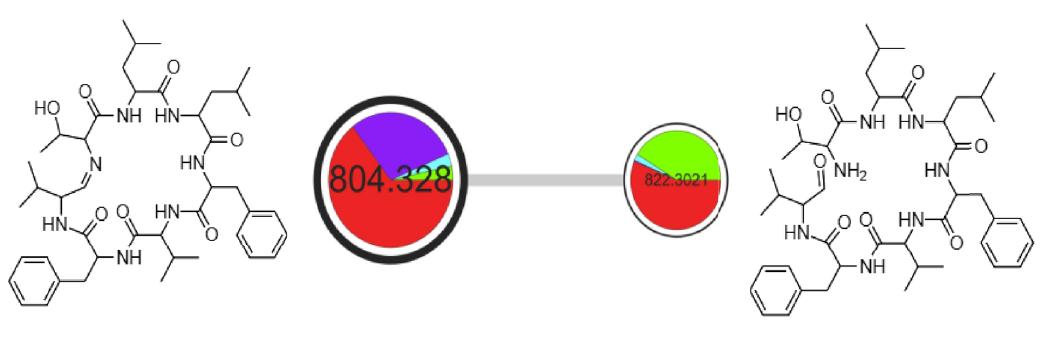
Figure 2. Characterization of koranimine from Peribacillus frigoritolerans BE93. ( a ) Relative abundance of the detected spectral features in tryptic soy broth (TSB) medium. Asterisk (*) represents koranimine. ( b ) Koranimine molecular network showing the structure of koranimine and its open aldehyde form. Pie chart represents relative abundance in each culture medium. ( c ) Elucidated tandem mass (MS/MS) fragmentation pathways of koranimine. ( d ) Time-dependent production of koranimine in TSB